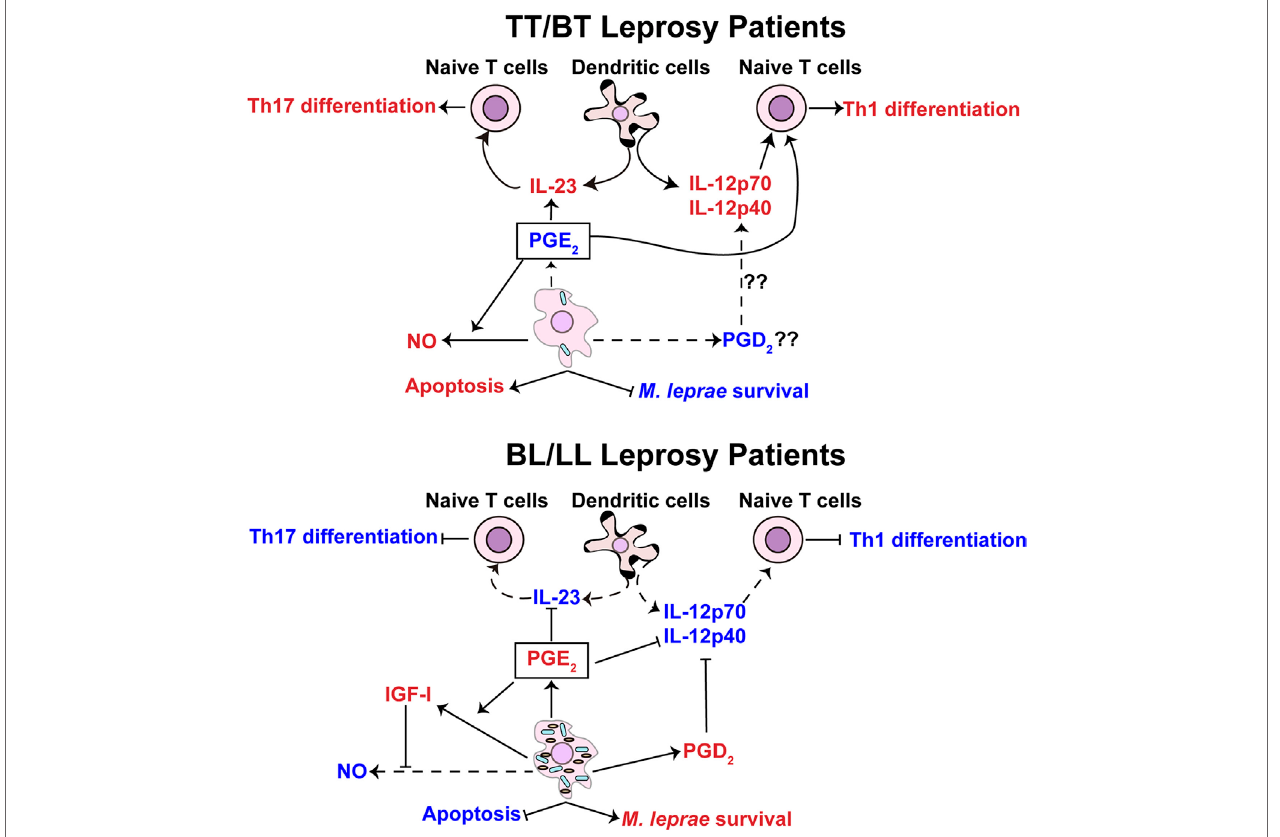
FigURe 5 | Prostaglandin E 2 is hypothesized to exhibit different functions in pauci- and multi-bacillary leprosy patients. Tuberculoid (TT)/borderline tuberculoid (BT) leprosy patients (top panel) display a lower concentration of PGE 2 in comparison with borderline lepromatous (BL)/lepromatous leprosy (LL) patients (lower panel). The lower concentration of PGE 2 in TT/BT patients is hypothesized to facilitate the differentiation of T-helper type 17 (Th17) cells through upregulation of interleukin (IL)-23 cytokine production by dendritic cells. Findings from Yao et al. (44) provide evidence that small amounts of PGE 2 may favor the differentiation of T-helper type 1 (Th1) cells in TT/BT individuals. The levels of PGE 2 in TT/BT patients may also promote the production of nitric oxide (NO) in M. leprae -infected macrophages leading to the control of the bacterial load. In BL/LL patients M. leprae -infected foamy macrophages/Schwann cells produce a higher level of PGE 2 that is hypothesized to inhibit the differentiation of Th1 cells through impairment of the production of IL-12p70 by dendritic cells. The higher concentration of PGD 2 , possibly secreted by foamy macrophages/Schwann cells from BL/LL patients, may also inhibit the production of IL-12p70. Additionally, the increased levels of PGE 2 could potentially inhibit the production of IL-23 in dendritic cells, thus blocking the differentiation of Th17 cells. Increased release of insulin-like growth factor I (IGF-I) stimulated via PGE 2 might potentially inhibit NO synthesis and apoptosis. The capacity of PGE 2 to prevent NO production and apoptosis favors the multiplication of M. leprae . The red color represents an intensification or increase in a process or abundance of a product, while the blue color symbolizes an attenuation of the process or product abundance. Arrows with solid lines indicate processes (production/secretion of cytokines, helper T-cell differentiation, apoptosis, and/or mycobacteria survival) that are favored or induced, while an arrow with a hashed line indicates processes that are not favored. ( ⊢ ) Represents inhibition of a process or